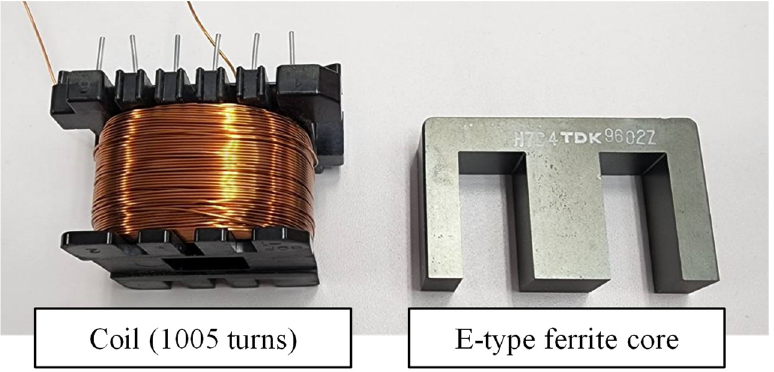
Figure 2. Coil and E-type ferrite core for the electromagnet. A ferrite core was inserted into the coil.